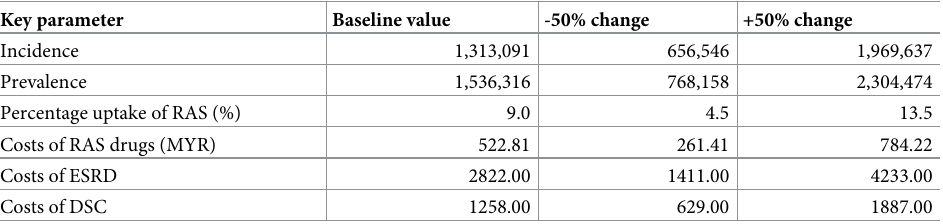
Table 2. Key parameter values for one-way sensitivity